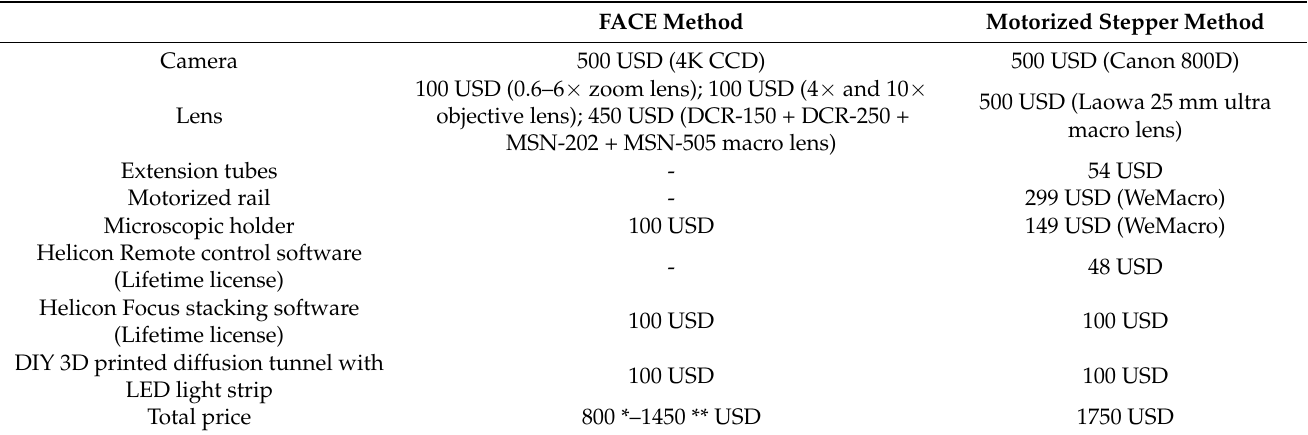
Table 1. A comparison of the instrument cost between the current FACE and motorized stepper